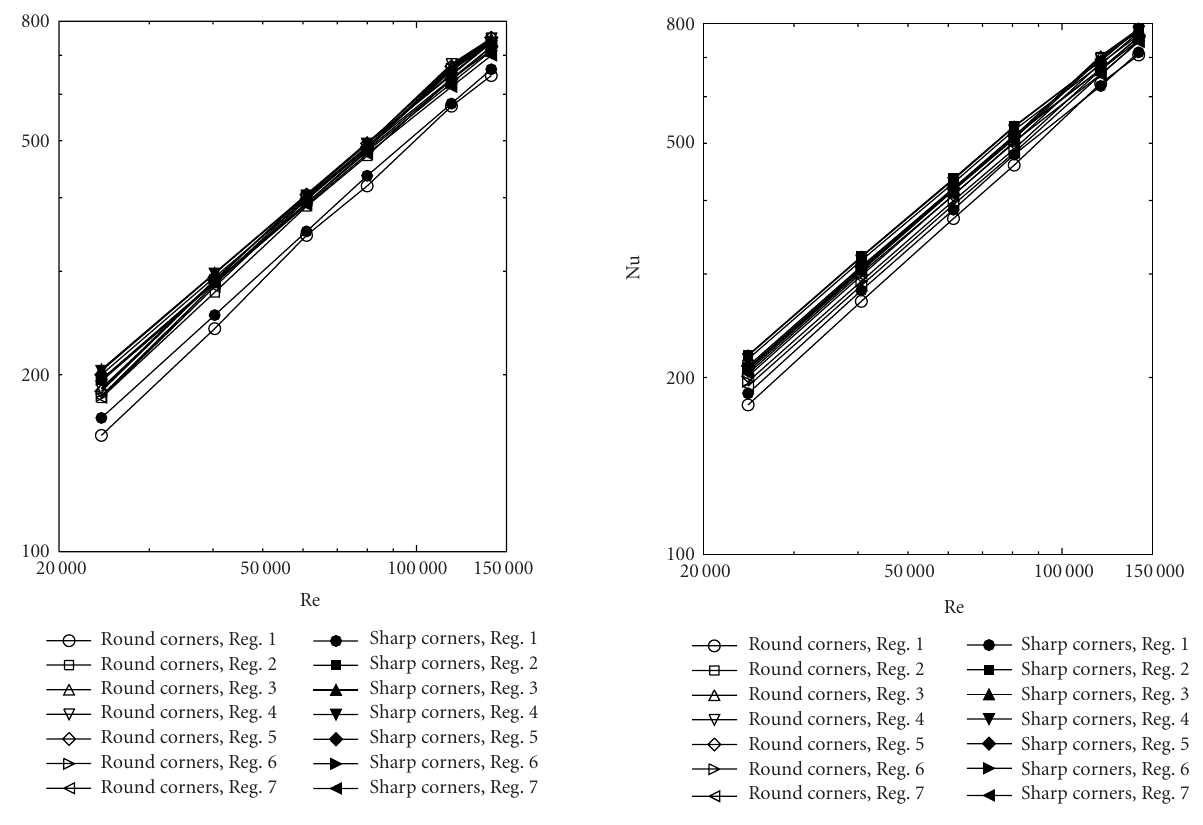
number region. Liquid crystal displays of isochrome